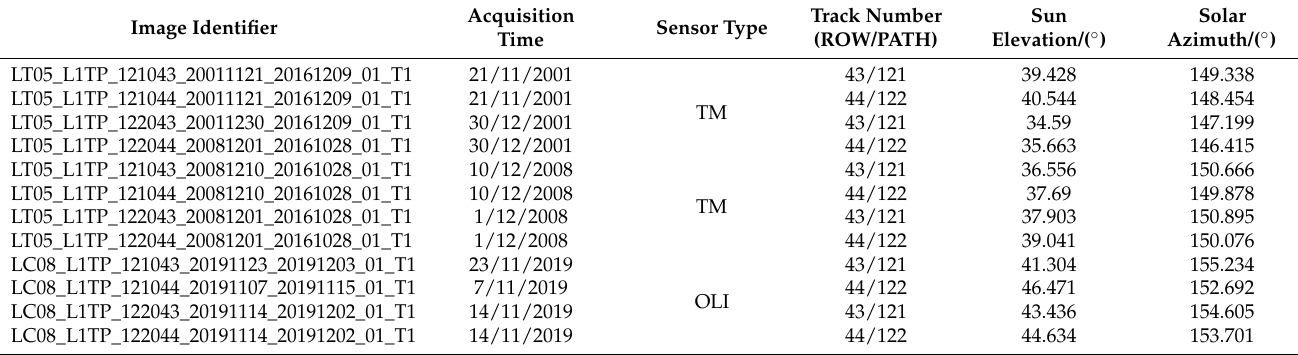
Table A1. Landsat image identifier, acquisition time, and type characteristics. Image